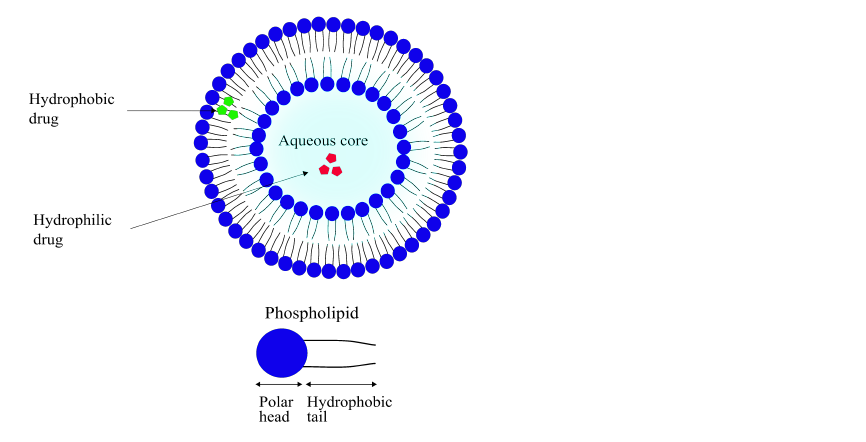
Figure 9. A schematic representation of a simple liposome with an aqueous core and phospholipid bilayer. Hydrophilic (red) as well as lipophilic drugs (green) can be encapsulated in